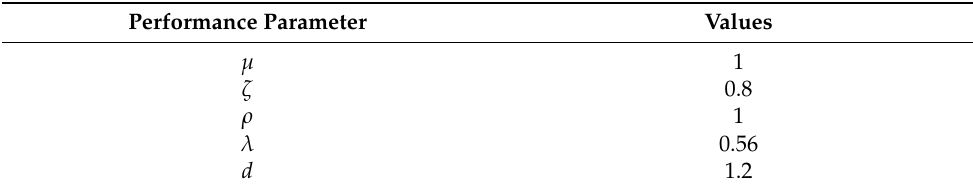
Table 2. Parameters setting for